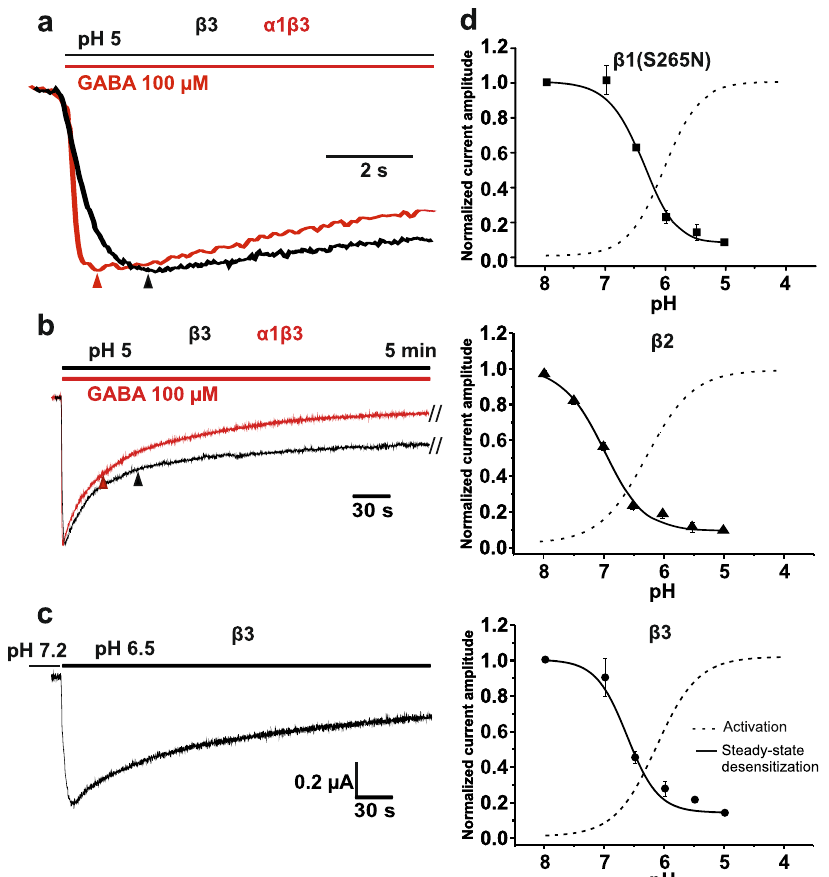
Fig. 2 Functional properties of proton-activated homomeric β receptors. a Activation kinetics of I H( β 3) (pH 5) through human homomeric β 3 receptors and I GABA (GABA 100 μ M, pH 7.2) through α 1 β 3 GABA A receptors at saturating agonist concentrations. The current traces illustrate slower activation of I H( β 3) ( t peak = 1.91 s) compared to I GABA ( t peak = 0.68 s). b Desensitisation kinetics of I H( β 3) and I GABA during long lasting exposure to pH 5 or to GABA 100 μ M. Desensitization half time for I H( β 3) is t 0.5 = 58.5 s compared to t 0.5 = 33.6 s of I GABA . pH in ( a, b ) was changed from 9 to 5. c Representative I H( β 3) induced by switching the pH from 7.2 to 6.5. d The pH-dependence of steady-state desensitization and of activation of receptors composed of the indicated β